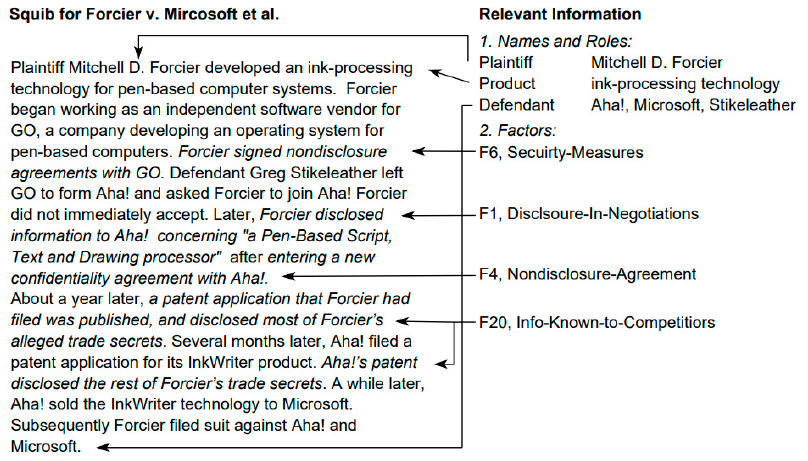
Figure 2. An example of textual representation and its relevant information [28].